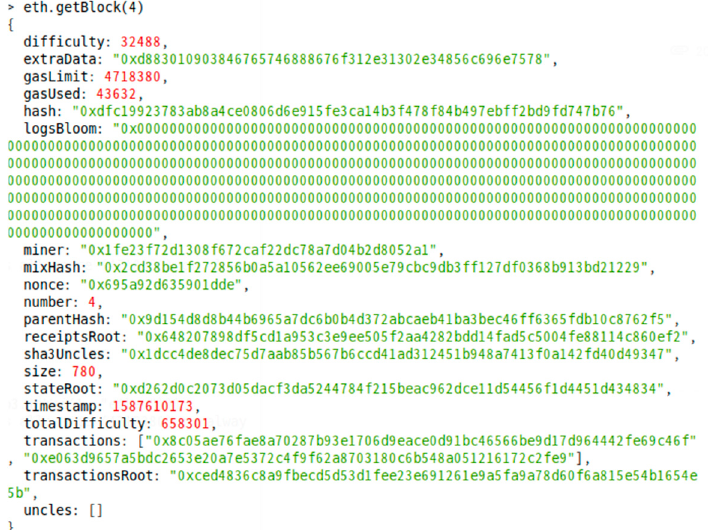
Figure 16. Generated block contents in Ethereum.